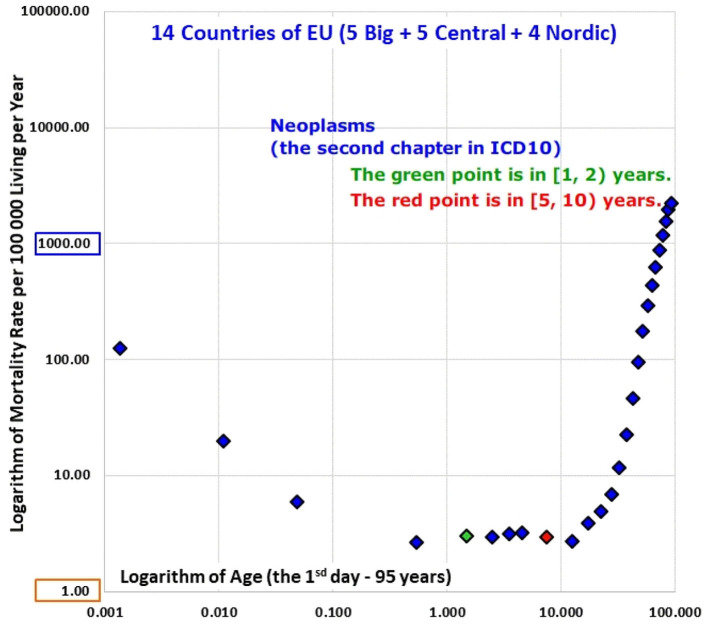
(Animation 4) Neoplasms in P14.